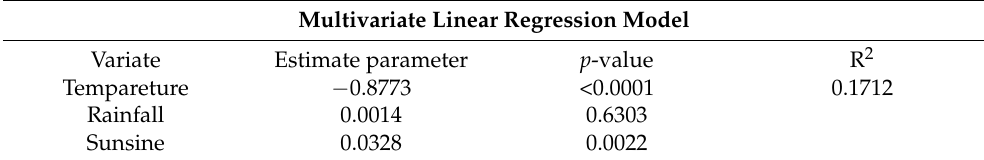
Table 2. Relationship between norovirus and climatic factors in Taiwan, 2015–2019.